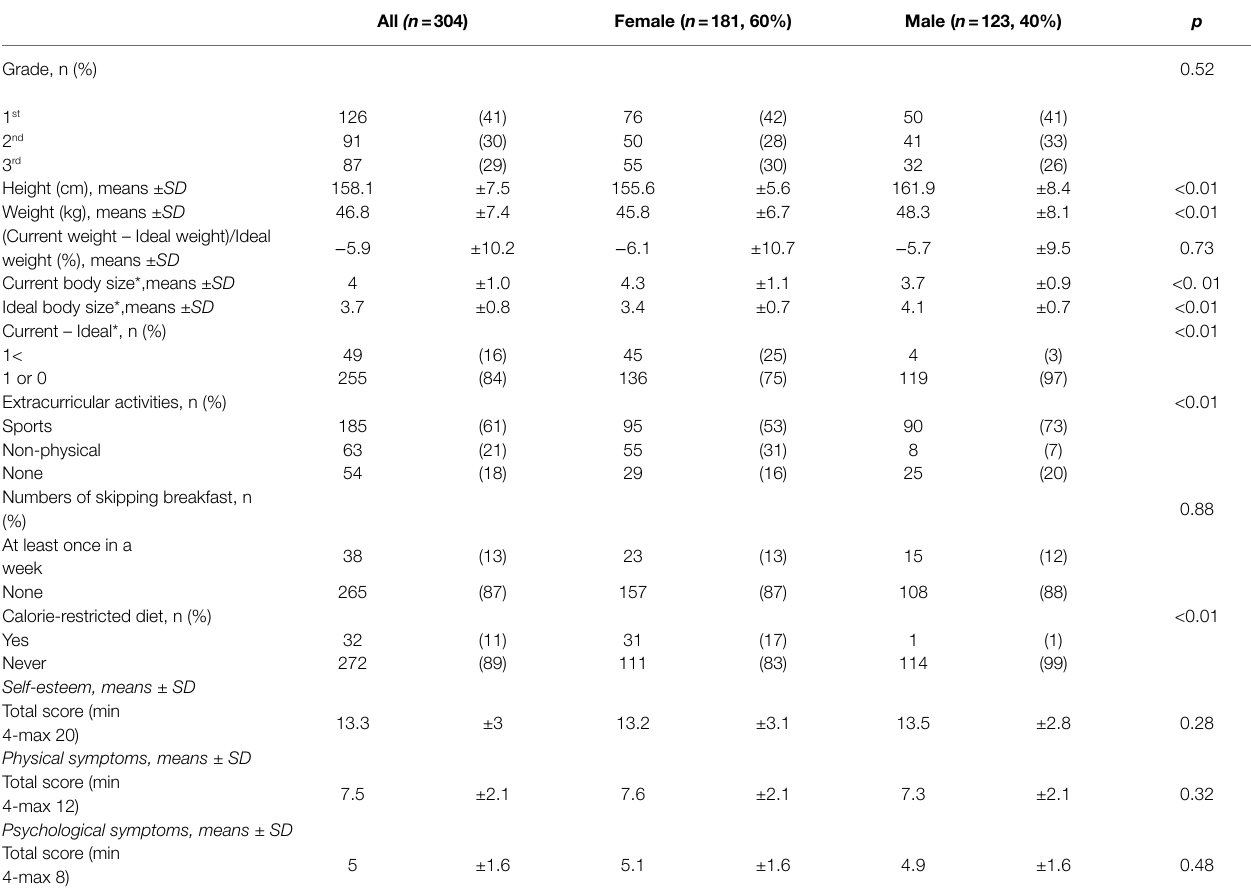
TABLE 1 | Subjects characteristics ( n =